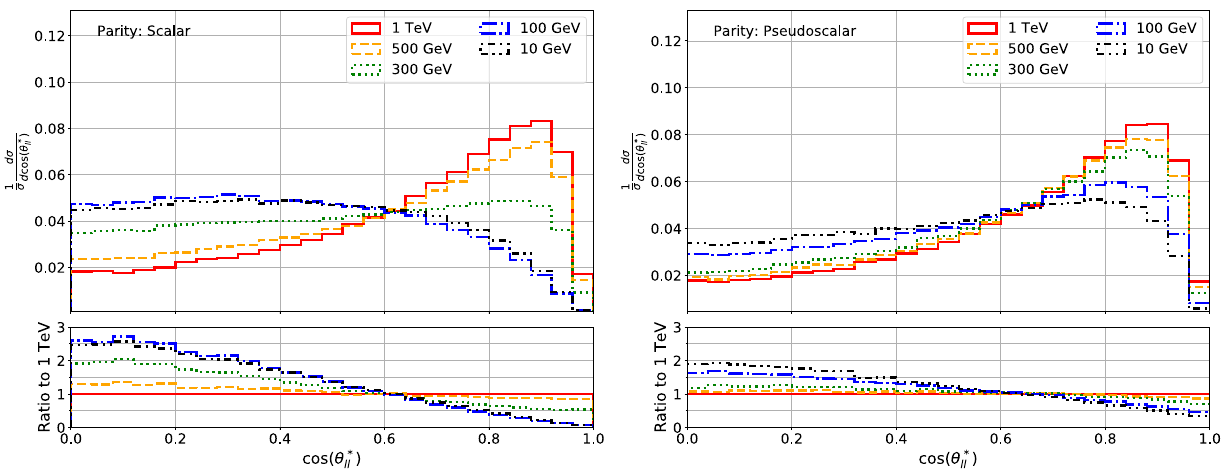
) distribu- = E / 3 with the NLO CT14 PDF set for the LHC with scale of μ DM √ T ll 0 s = 13 TeV. The lower panels depict the ratio center of mass energy to the distributions for m Y = 1